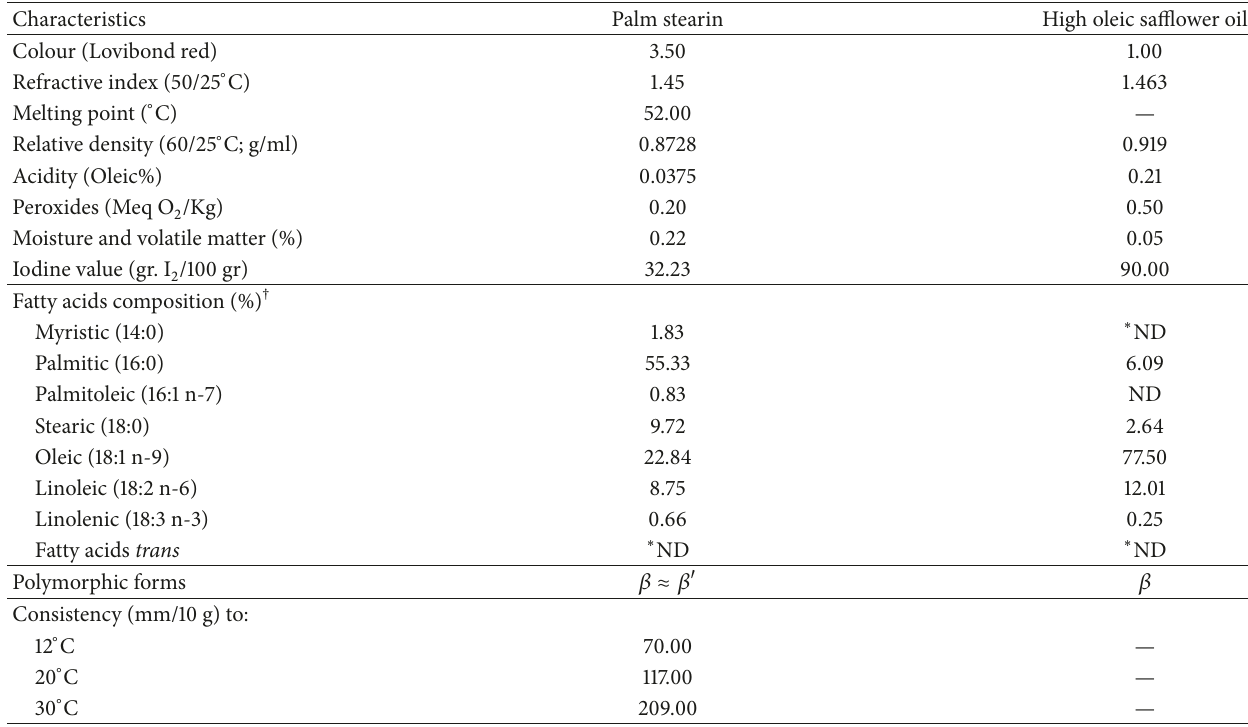
Table 1: Physical properties, fatty acid compositions, and consistencies of palm stearin and high oleic safflower oil 1 . Characteristics